Question: What visual encoding does this figure use to show its data?
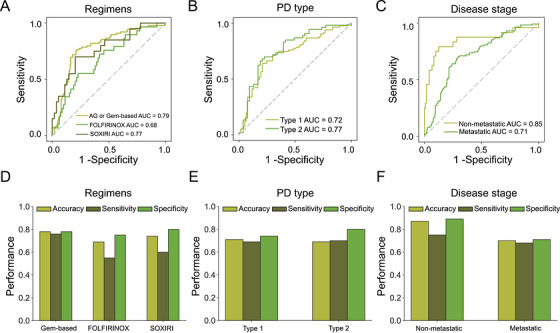
Answer: bar